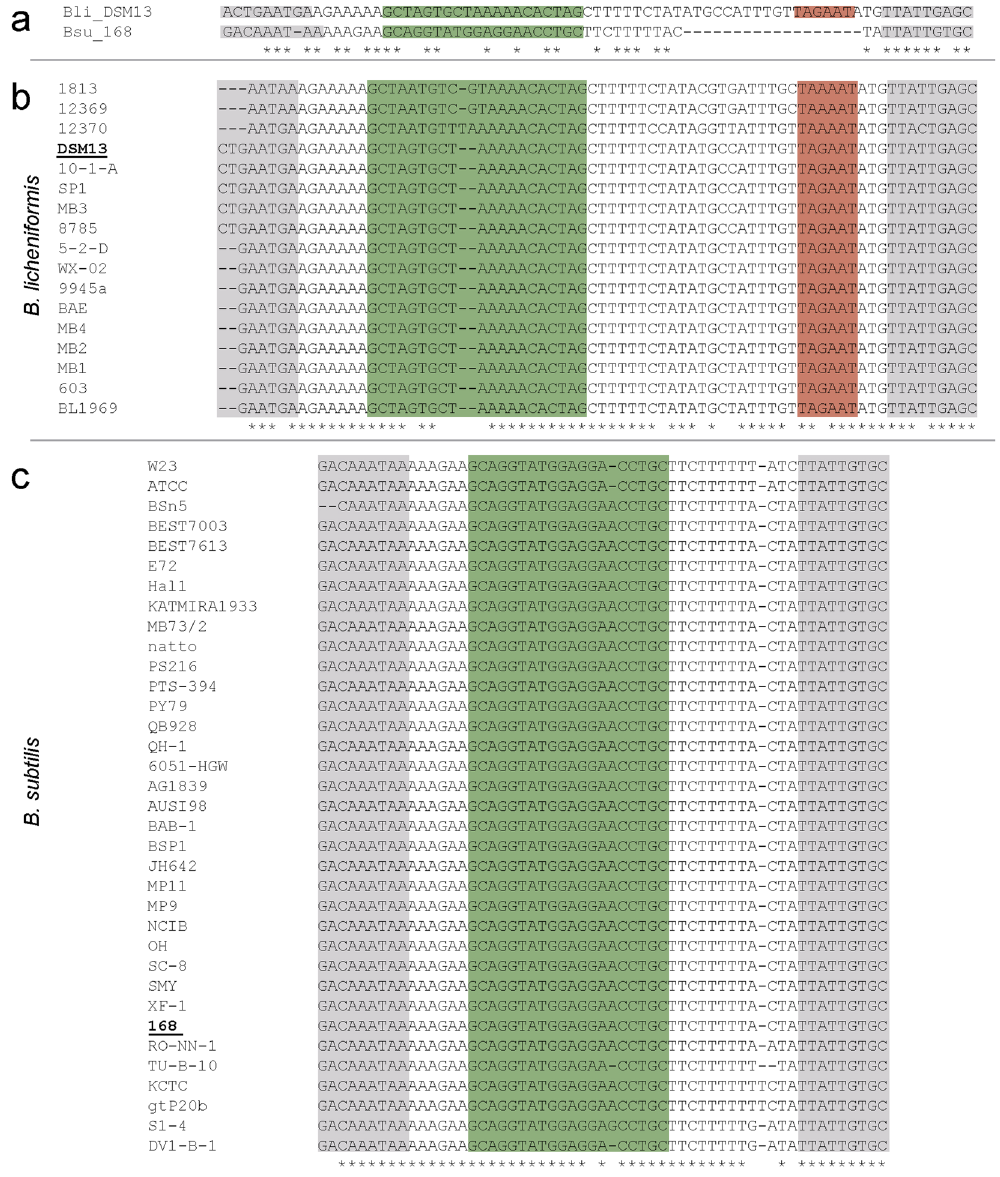
Figure 5. Alignment of AprAs promoter sequences from B . licheniformis and B . subtilis strains . Protein coding sequences are marked in grey. Transcription terminator sequences are marked in green and the promoter regions ( − 10 box) in red. The alignment was performed using MUSCLE 53 . ( a ) Sequence alignment of B . licheniformis DSM13 (NC_006270) and B . subtilis 168 (NC_000964). B . subtilis 168 lacks the − 10 box upstream of the aprAs gene of B . licheniformis DSM13. ( b ) Sequence alignment of 17 B . licheniformis strains. The AprAs − 10 box is present in all strains. ( c ) Sequence alignment of 35 B . subtilis strains. The AprAs − 10 box is absent in all